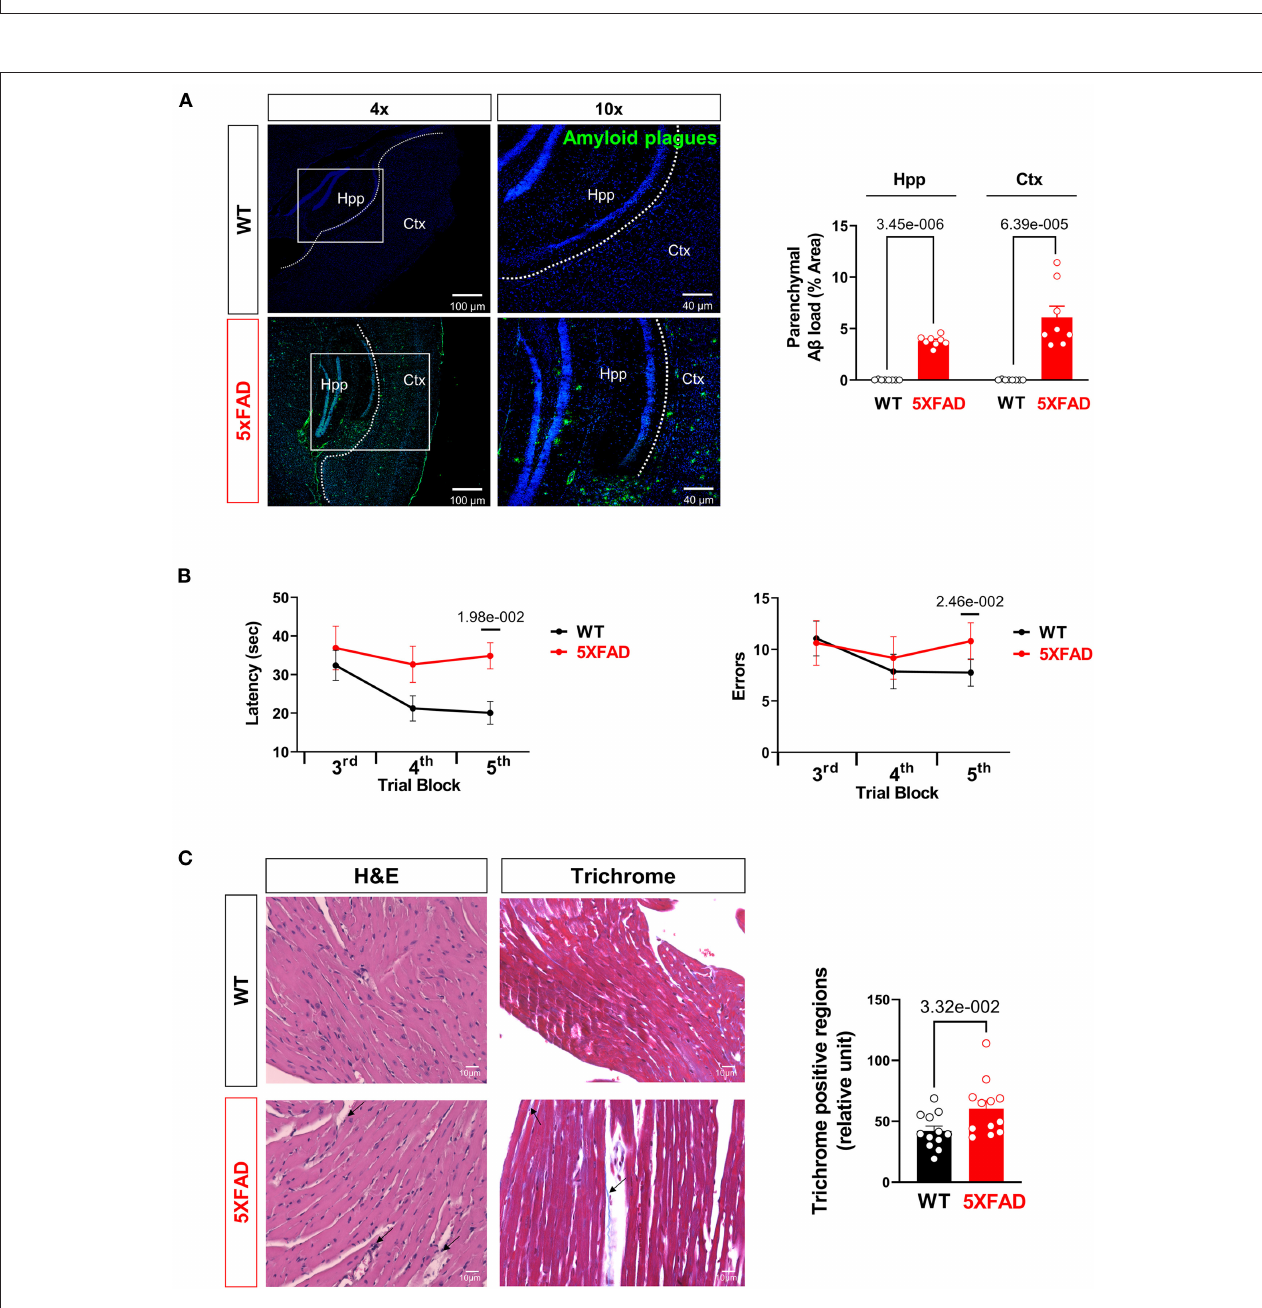
FIGURE 5 | A β burden and cognitive function assessment in AD mice. (A) Representative images and quantification of A β stained with 6E10 antibody in the hippocampus and cortex of 5XFAD (6 months) mice and WT (6 months) mice. Biological replicates N = 8 for each group. P -value determined by two-tailed students t -test. (B) Radial arm water maze test showed the latencies to hidden platform and the errors happen in arms in WT (6 months) and 5XFAD (6 months) mice. Biological replicates N = 8 for each group. P -value determined by two-tailed students t- test. (C) Myocardial histology analysis showed elevated fibrosis in 5XFAD (6 months) mice heart compared to the WT (6 months) group. Biological replicates N = 3 for each group. P -value determined by two-tailed students t- test. Black arrows highlighted the inflammatory infiltration and fibrosis formation in 5XFAD (6 months) heart H&E staining and Trichrome staining, respectively.